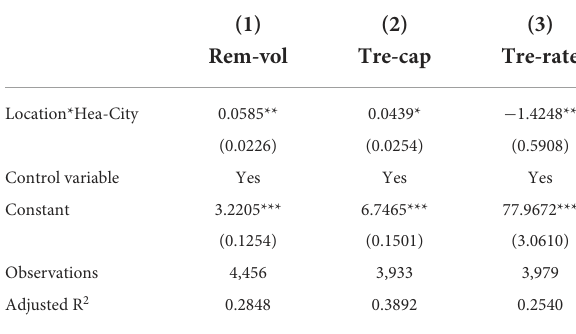
TABLE 8 Heterogeneity by city